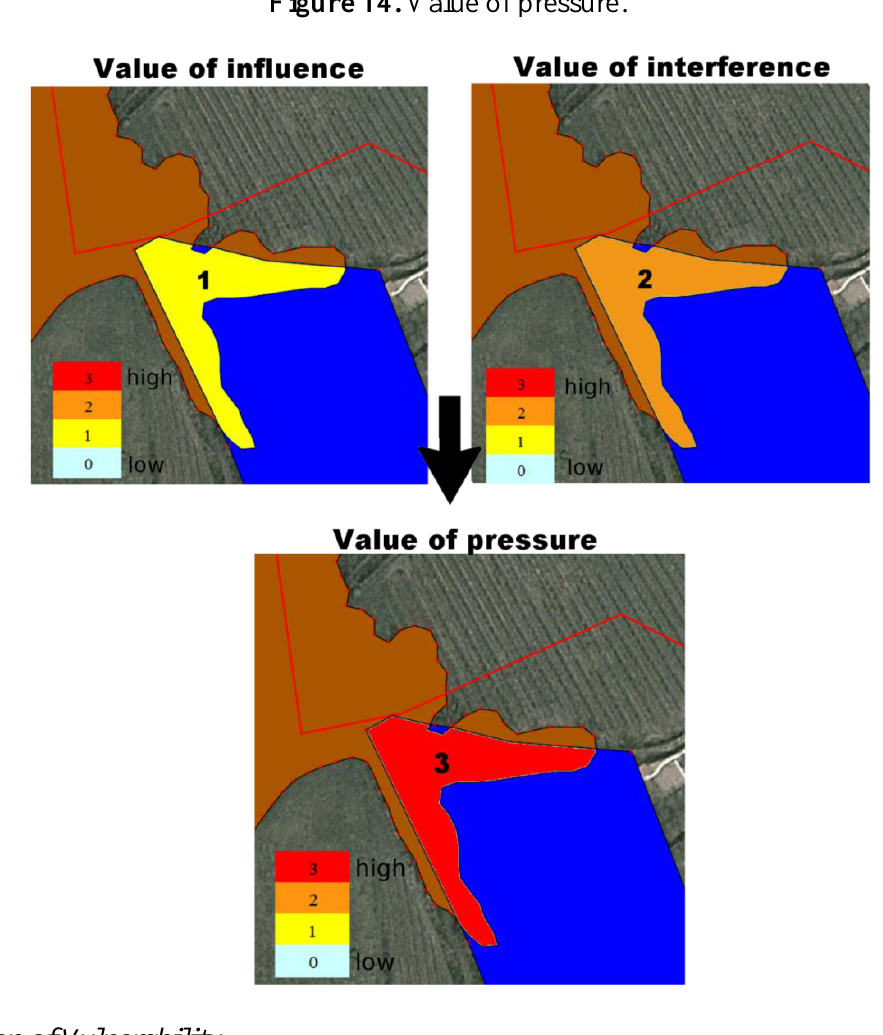
Figure 14. Value of